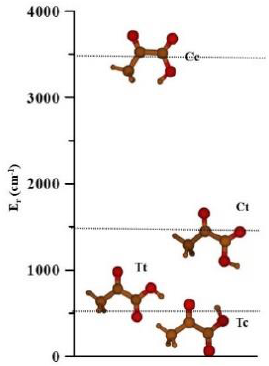
Figure 2 represents the relative stabilities of the four conformers. The CCSD(T)- F12/AVTZ-F12 structural parameters and MP2/AVTZ anharmonic vibrational frequencies are collected in Tables 2 and 3, respectively.